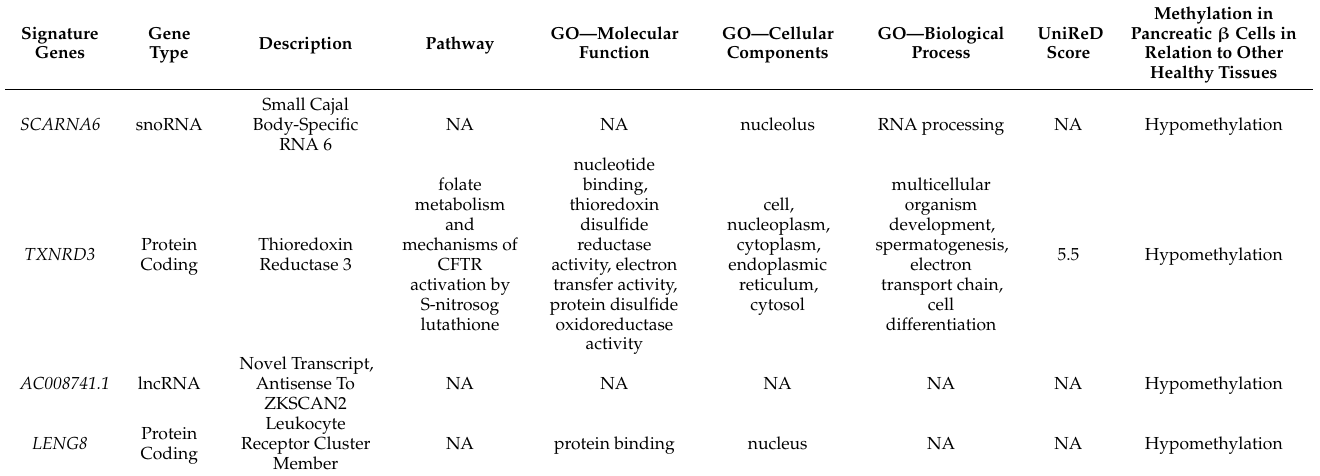
Table 3. Differentially methylated genes selected in the pancreatic β -cell-specific signature built using AutoML analysis comparing methylomes of β -cells and other healthy tissues. Their biological characteristics and functions revealed by GO analysis as well as their methylation status are